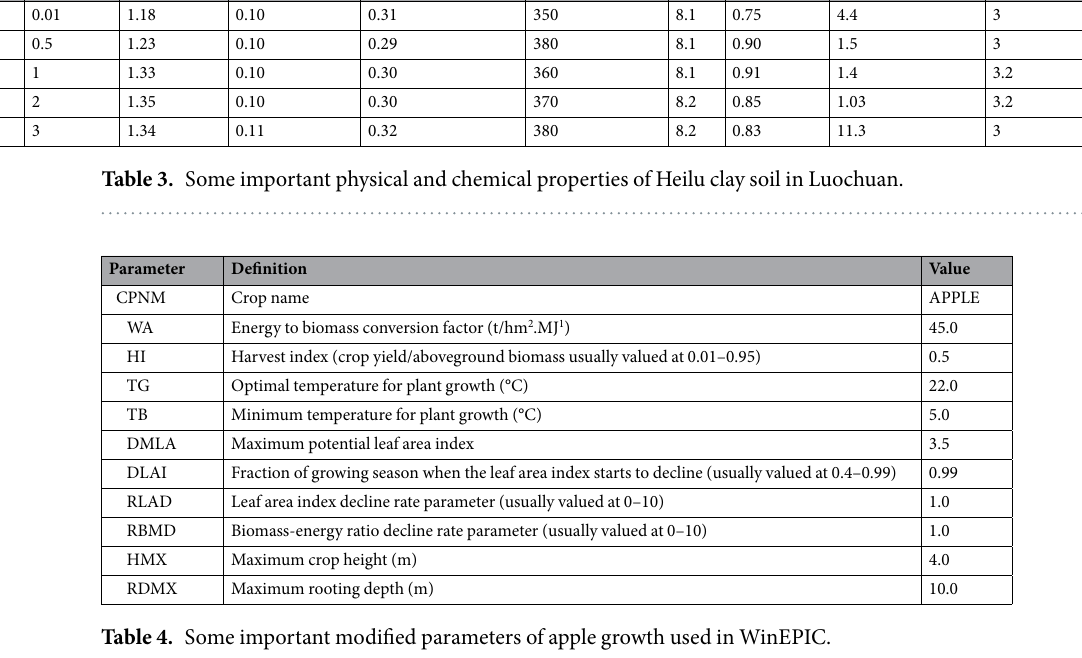
Table 4. Some important modified parameters of apple growth used in